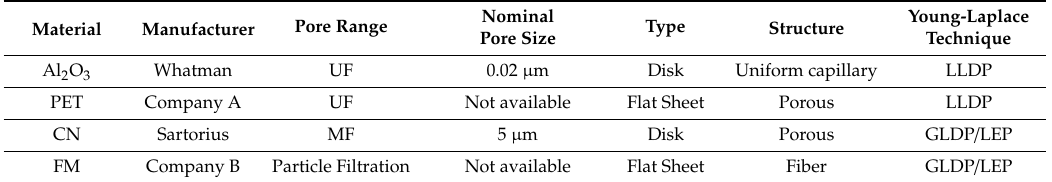
Table 1. Characteristics of the four membranes analyzed and porometric technique / s